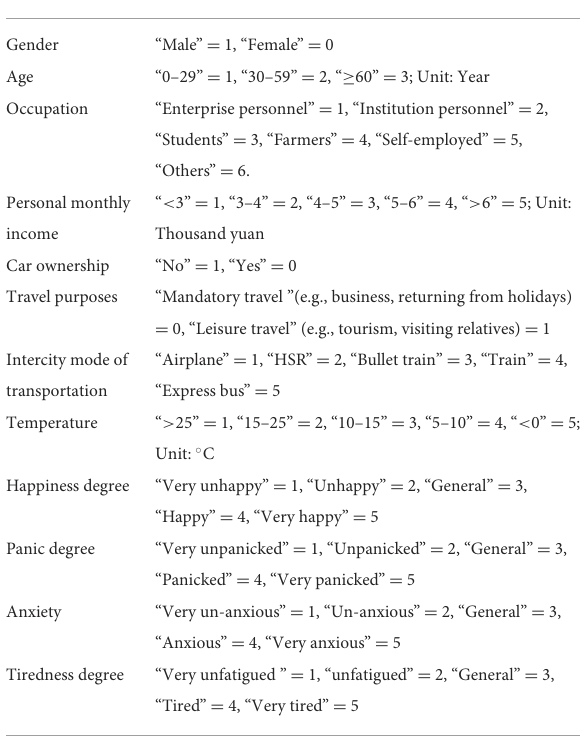
TABLE 2 Variable definitions and